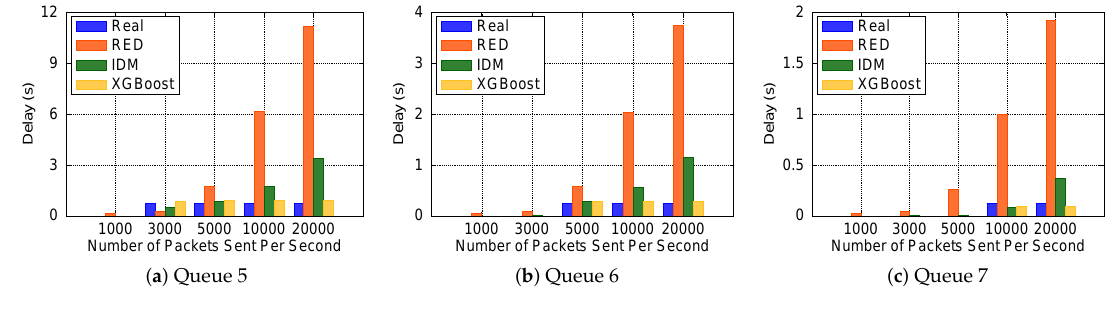
Figure 5. Queuing delay prediction methods